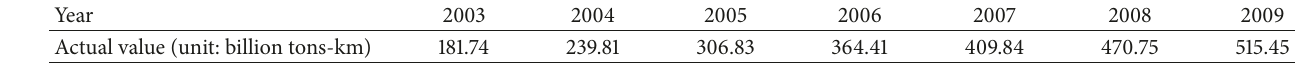
Table 3: The actual values of the turnover of goods in Jiangsu Province, China.